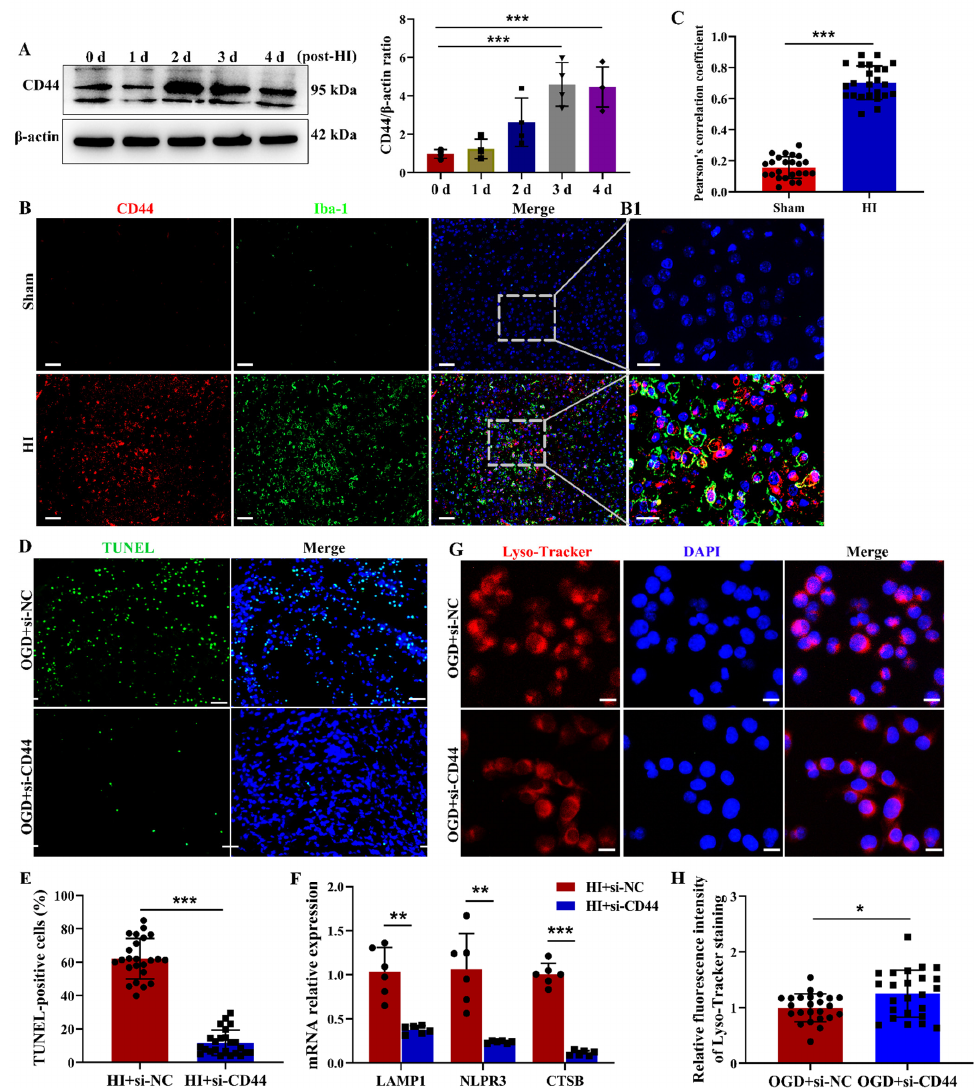
Figure 7. Role of CD44 in HI-induced lysosome leakage and CTSB release. ( A ) CD44 protein in the ipsilateral cortex was assessed at 0 d, 1 d, 2 d, 3 d, and 4 d post-HI by Western blot ( n = 4). All experiments were performed three times. ( B , C ) Immunofluorescence images and quantitative measurements revealed the colocalization of CD44 and Iba-1 ( n = 4). Scale bar = 50 µ m. B1: Magnified views of the boxed regions in ( B ) showing the colocalization of CD44 and Iba-1. Scale bar = 20 µ m. ( D , E ) TUNEL staining at 3d following HI-injured mice pre-treated with si-CD44 or si-NC ( n = 4). Scale bar = 50 µ m. ( F ) LAMP1, NLRP3, and CTSB mRNAs in HI+si-NC or HI+si-OPN group were assessed by qRT-PCR ( n = 6). ( G , H ) BV-2 cells were exposed to OGD after transfection with si-NC and si-OPN, followed by incubation with Lyso-Tracker Red ( n = 6). Scale bar = 20 µ m. Values represent the mean ± SD, *** p < 0.001 according to one-way ANOVA with Dunnett corrections in ( A ). * p < 0.05, ** p < 0.01, *** p < 0.001 according to the t -test in ( C , E , F , H ). CTSB, cathepsin B; DAPI, 4 (cid:48) ,6 (cid:48) -diamidino-2-phenylindole dihydrochloride hydrate; HI, hypoxia–ischemia; Iba-1, ionized calcium-binding adapter molecule 1; LAMP1, lysosomal-associated membrane protein 1; NC: negative control; NLRP3, NOD-like receptor thermal protein domain associated protein 3; TUNEL, terminal deoxynucleotidyltransferase-mediated dUTP-biotin nick end labeling; OGD, oxygen–glucose